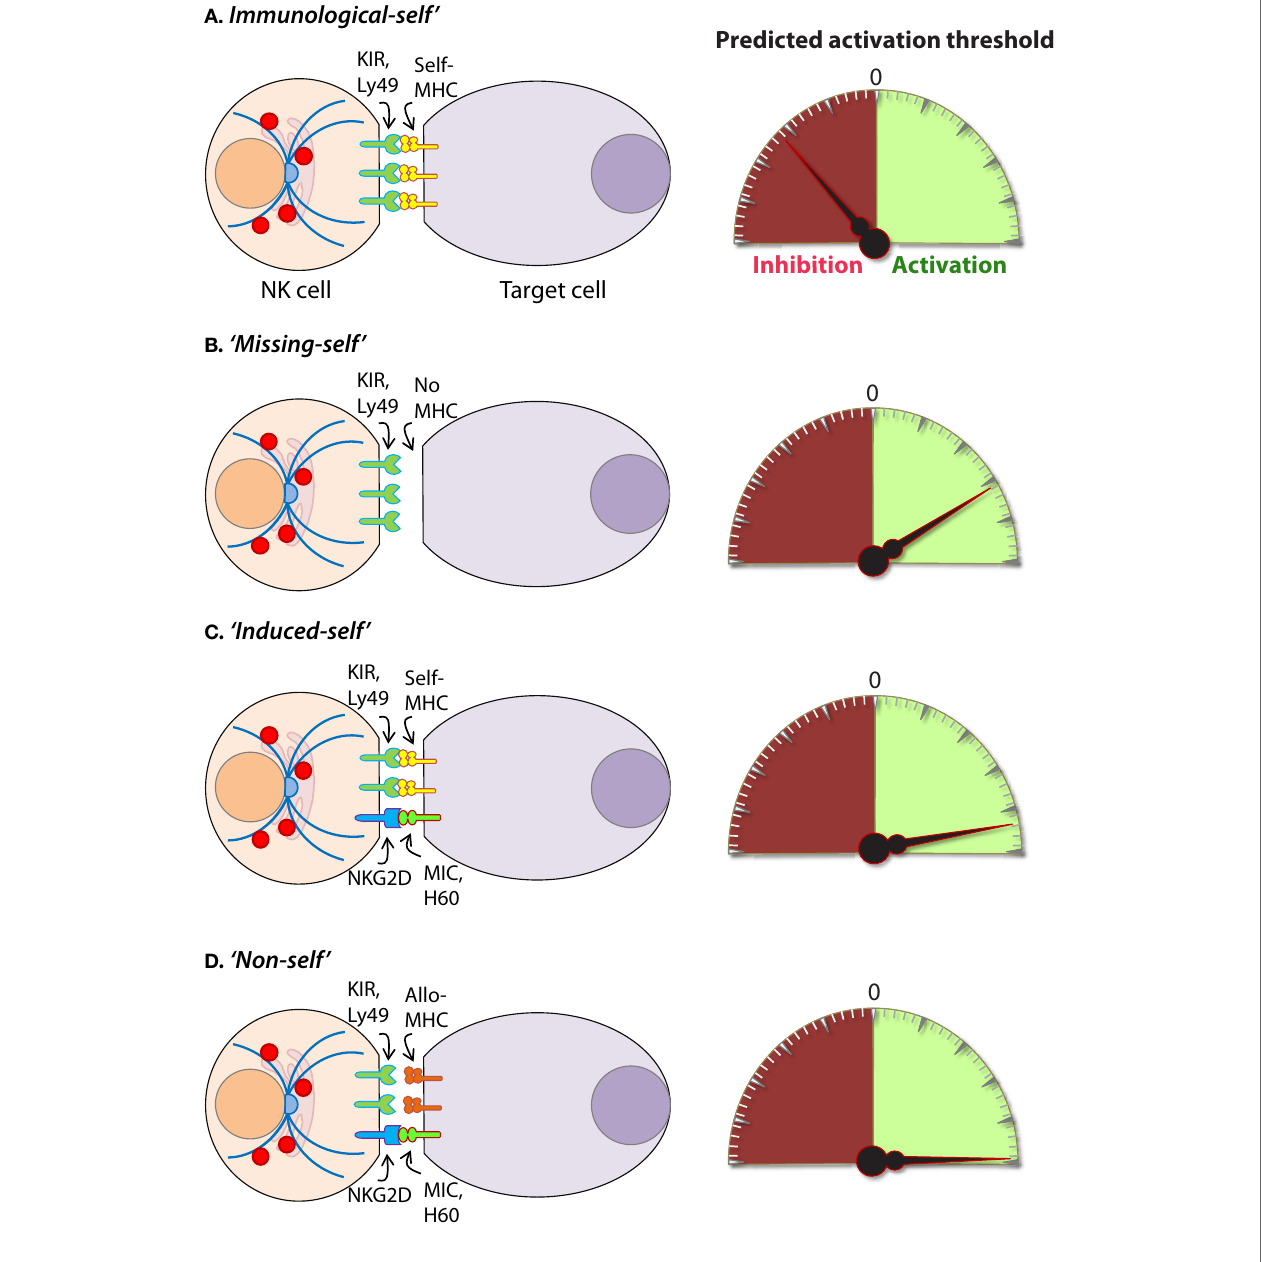
FiGURe 8 | Mechanisms of target cell recognition by natural killer (NK) cells. NK cells lack clonotypic receptors and rely on germline-encoded activation and inhibitory receptors to recognize other cells around them. The following are some of the primary mechanisms by which NK cells perceive target cells. (A) “ Immunological Self ”: recognition of autologous MHC class I (MHC-I) (human leukocyte antigen (HLA)) or histocompatibility antigen-2 (H2, mouse) by inhibitory receptors [killer cell immunoglobulin-like receptor (KIR) or Ly49] let the NK cells know that they are interacting with normal cells and contain their activation. (B) “ Missing-self ”: recognition of target cells that either does not express MHC-I or reduce them below optimal levels can induce NK cell activation. (C) “ Induced-self ”: recognition of activating ligands that are expressed on target cells by the germline-encoded receptors such as NKG2D (H60, mouse; MIC-A/B, human), Ly49H (murine cytomegalovirus-derived m157, mouse), NCR1 (a number of viral proteins) can overcome MHC-I-mediated inhibitory signaling resulting in NK cell activation. (D) “ Non-self ”: recognition of transplanted tissue by NK cells, where the donor tissue expresses either allogeneic or haploidentical